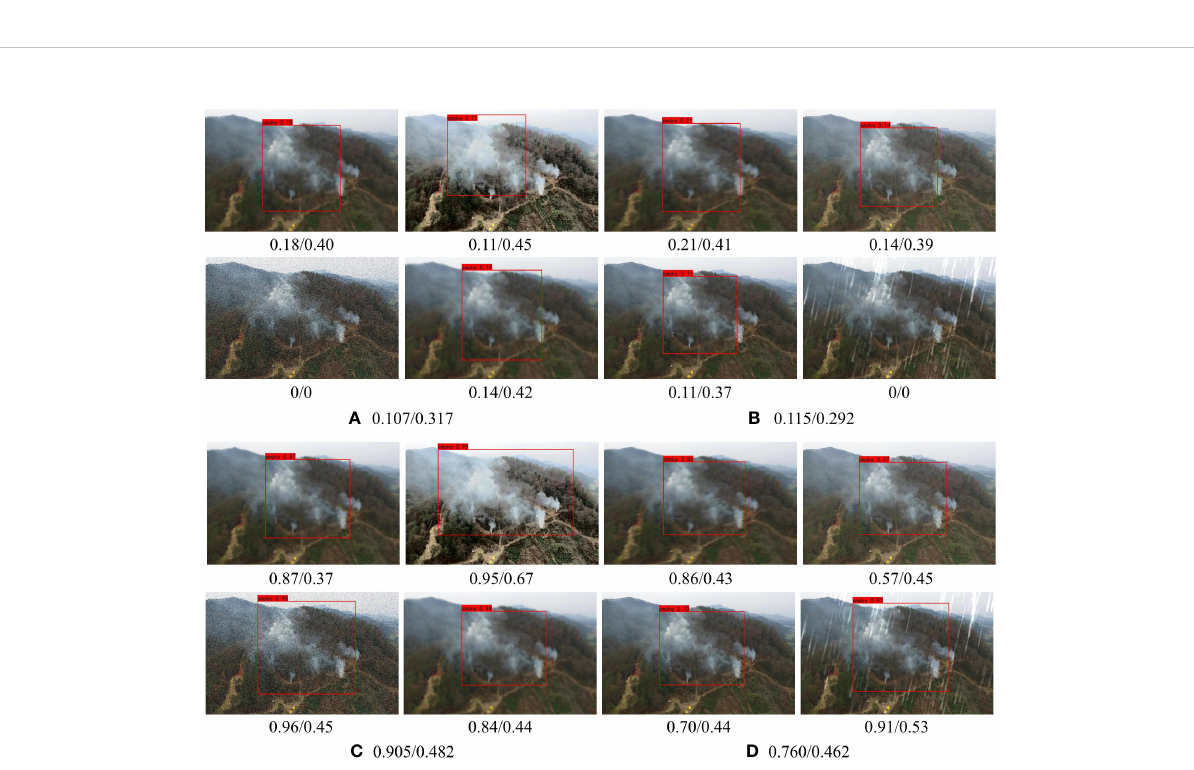
FIGURE 10 Ablation experiment of anti-disturbance ability of SAC to different degraded